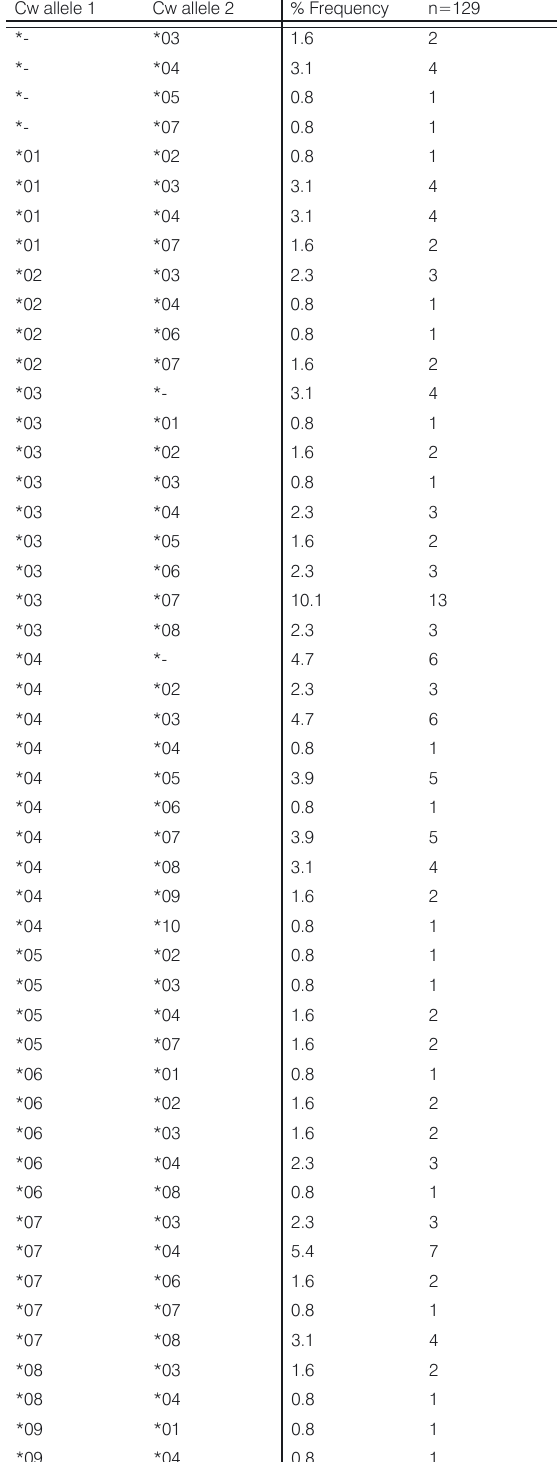
Table 1. HLA-Cw genotype in healthy Mexican individuals (organ donors).